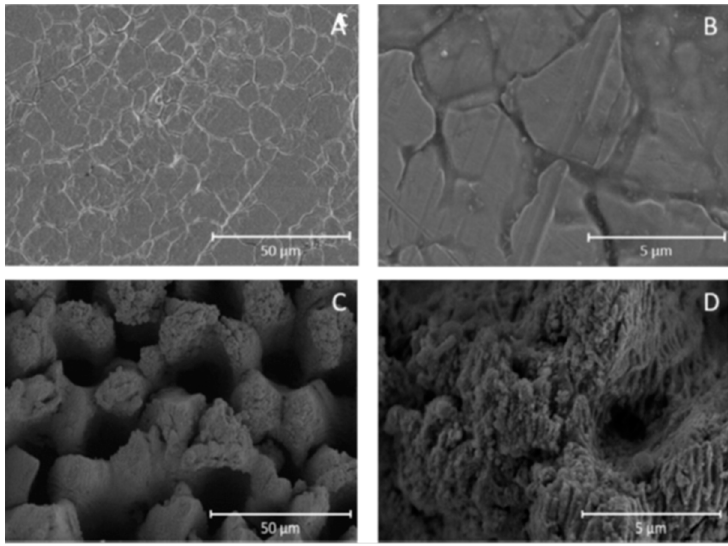
Figure 11. SEM images of native ( A , B ) laser-irradiated structure on steel ( C , D ), which was used for SLIPS fabrication. (Reprinted with permission from [89]. Copyright 2017 American Chemical Society.)